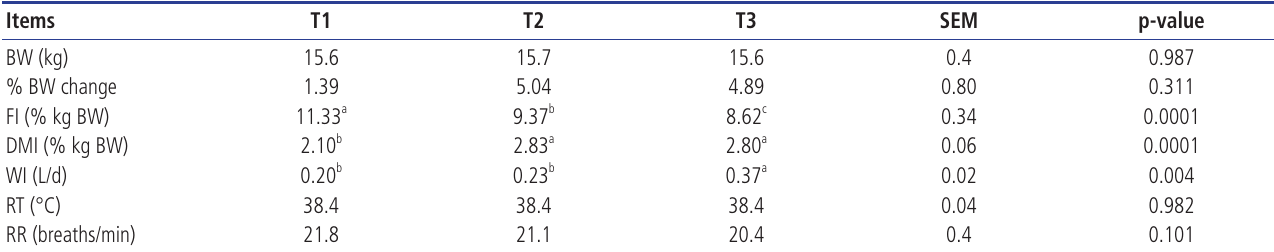
Table 2. Changes of body weight, intake of feed, dry matter and water, rectal temperature and respiratory rate in goats fed three different diets recorded for a period of 28 days duration Items T1